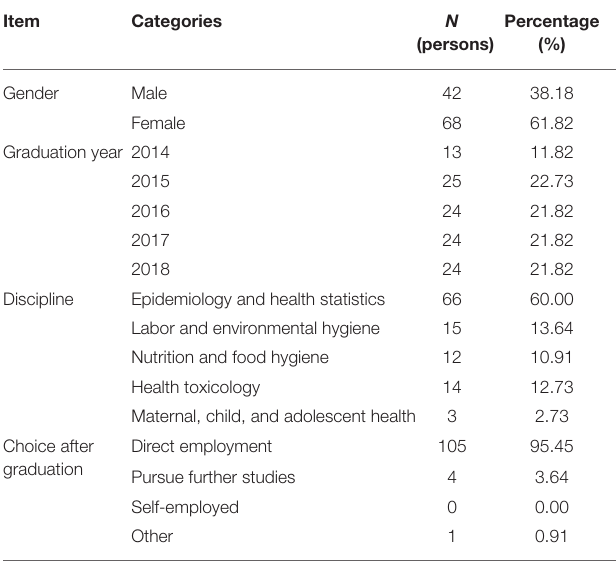
TABLE 1 | Basic information for PHPM Master’s graduates.